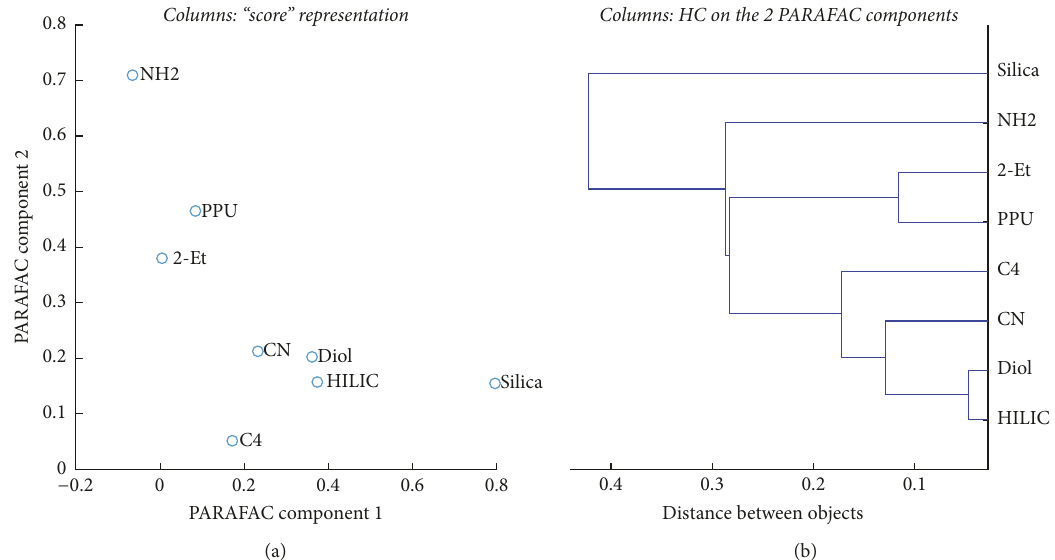
Figure 6: PARAFAC analysis of the chromatographic columns: the two columns of matrix 𝐶 used as 𝑥 and 𝑦 coordinates (a) and HC performed on these coordinates (b).